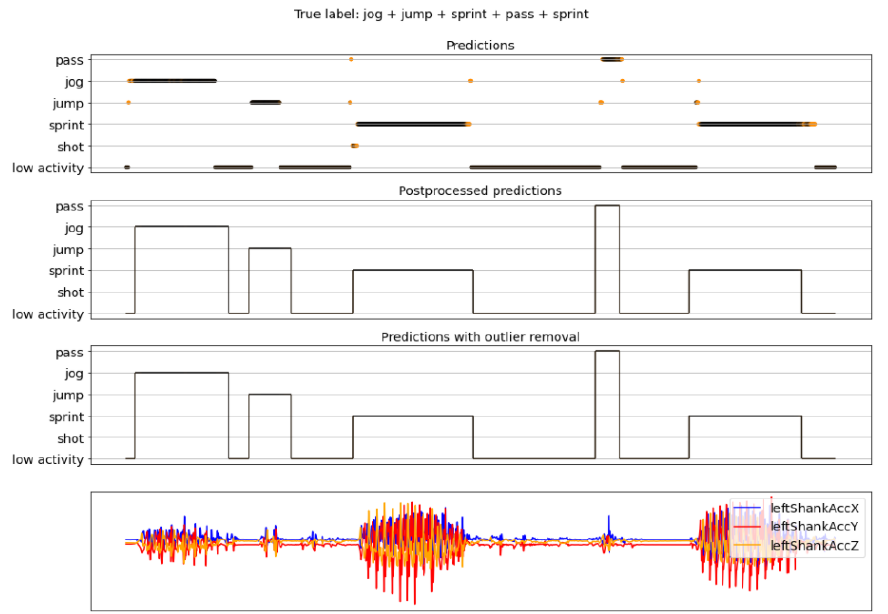
Figure 19. Example 1 of final results. True labels (in order): jog, jump, sprint, pass, and sprint with low activity periods in between each one of them. For the activity prediction plot, the orange-black color code of the dots and lines in the predictions represents the confidence of the predictions, where orange means low confidence and black high.